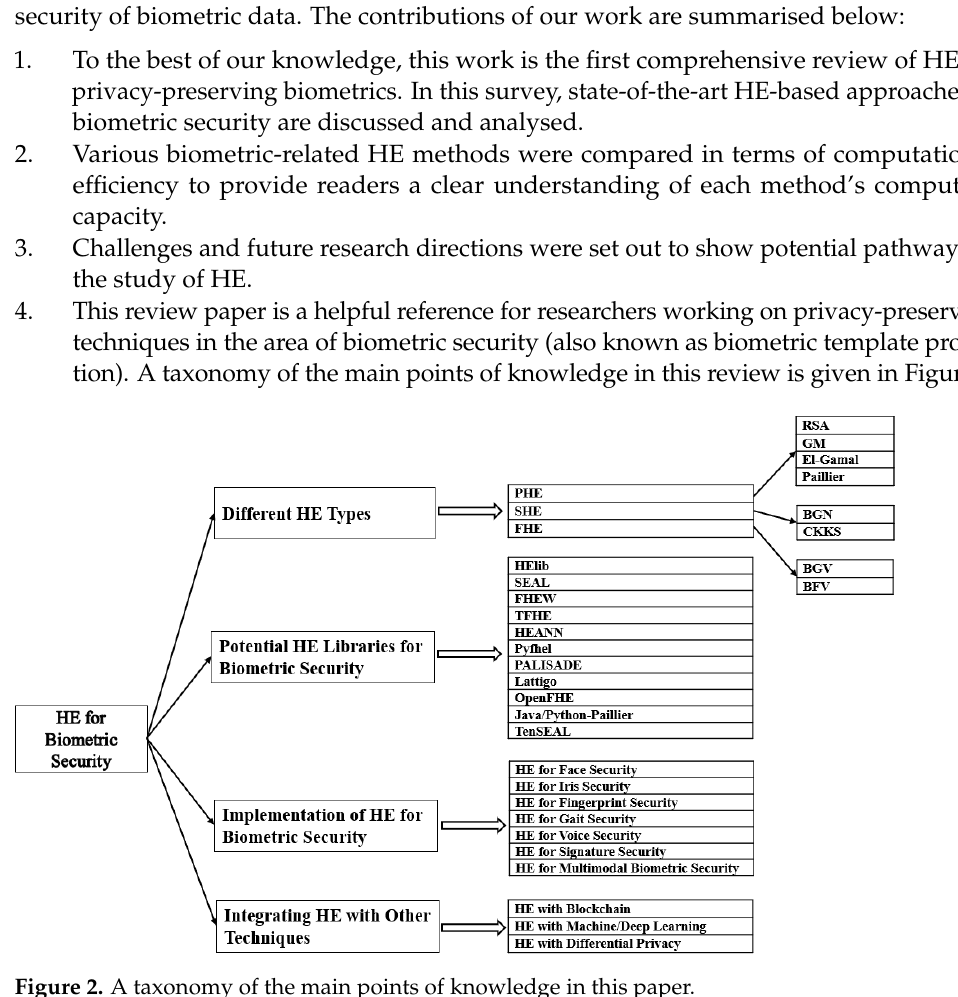
Figure 2. A taxonomy of the main points of knowledge in this